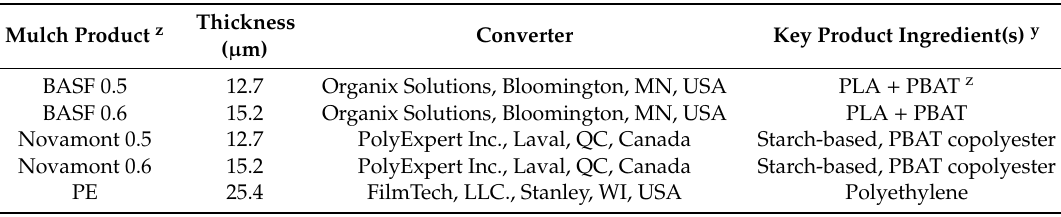
Table 1. Polyethylene (PE) and biodegradable plastic mulch (BASF and Novamont) treatments applied to tissue culture “Wake TM Field” raspberry in May 2017 in Northwestern WA,